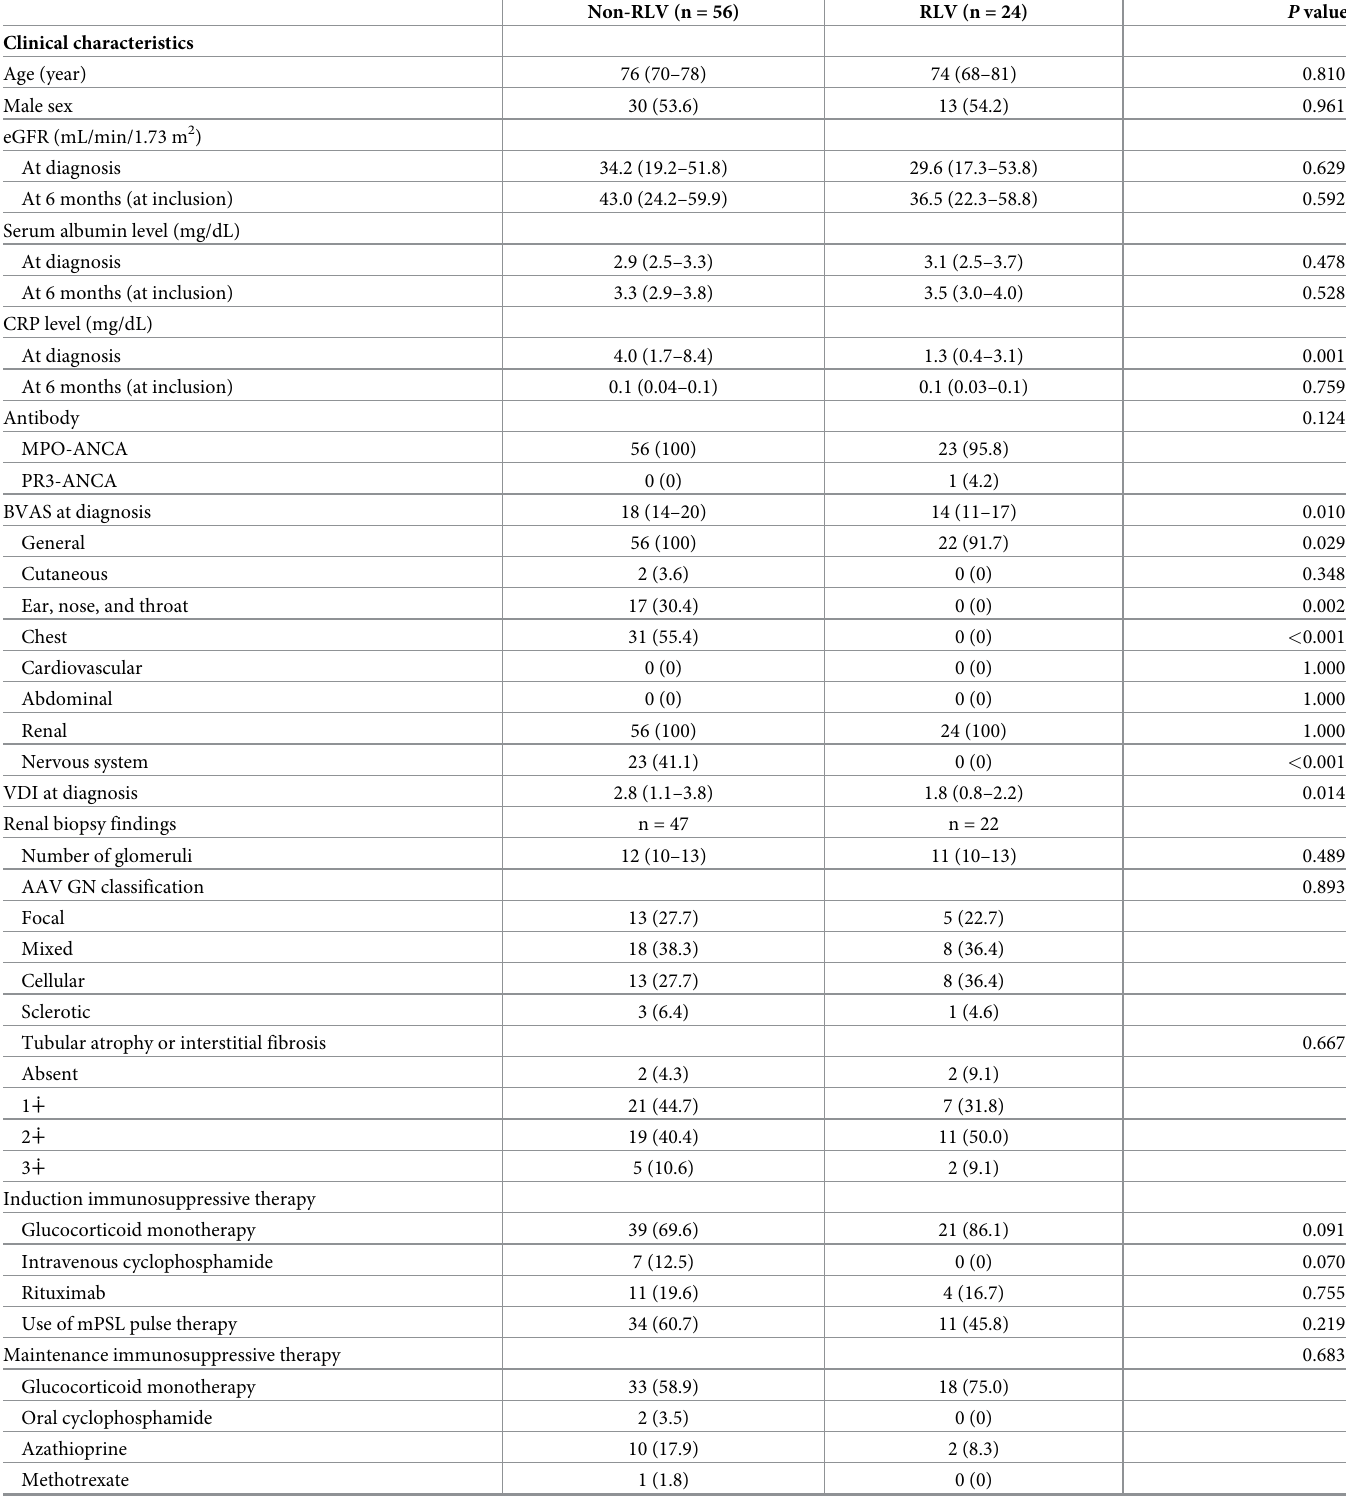
Table 1. Clinical characteristics of 80 patients in RLV and non-RLV groups who had achieved remission at 6